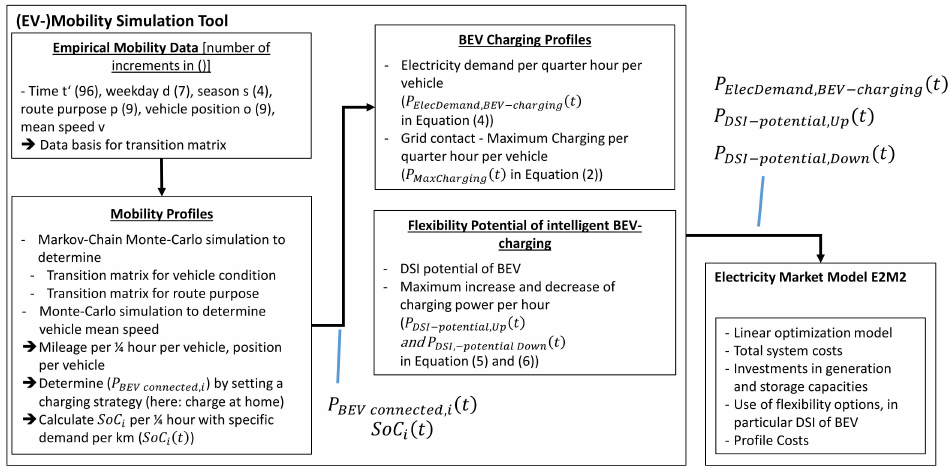
Figure 1. Overview of the approach presented in this